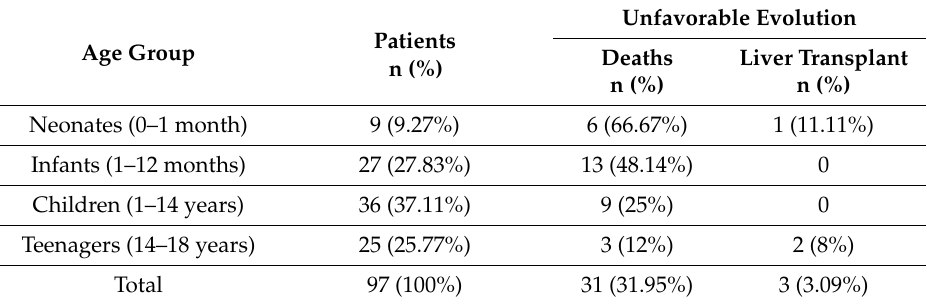
Table 1. Distribution of children hospitalized with acute liver failure (ALF) by age group and their outcome.